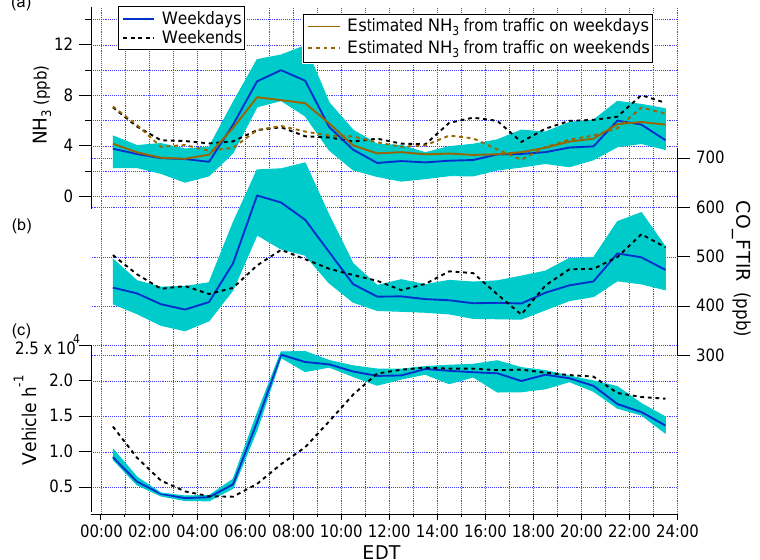
Figure 5. Average weekday and weekend diurnal cycles of mixing ratio of NH 3 (a) and CO (b) from the FTIR spectrometer and traffic volume (c) for the 16-day study period. Blue solid lines are medians, and the shaded areas show the interquartile ranges for weekdays; black dashed lines are the medians for weekends. The brown solid line is an estimation of NH 3 levels associated with traffic emissions on weekdays; the brown dashed line corresponds to weekends.